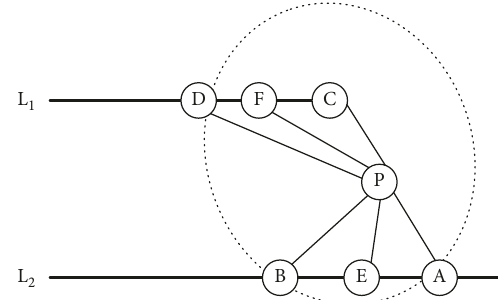
Figure 3: Distance and matching method based on equal prob- ability geographic